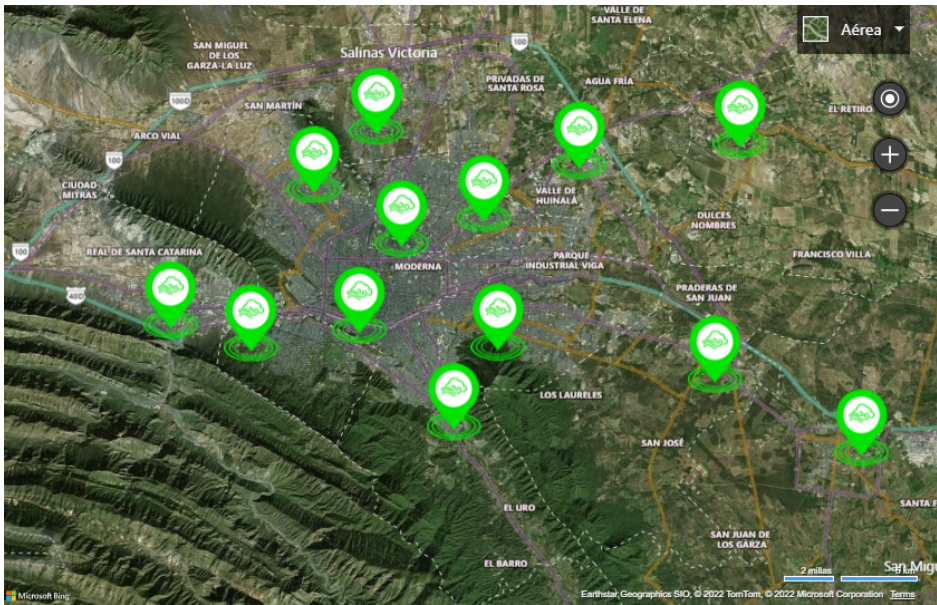
Figure 8. Active station part of the integral system for environmental monitoring in